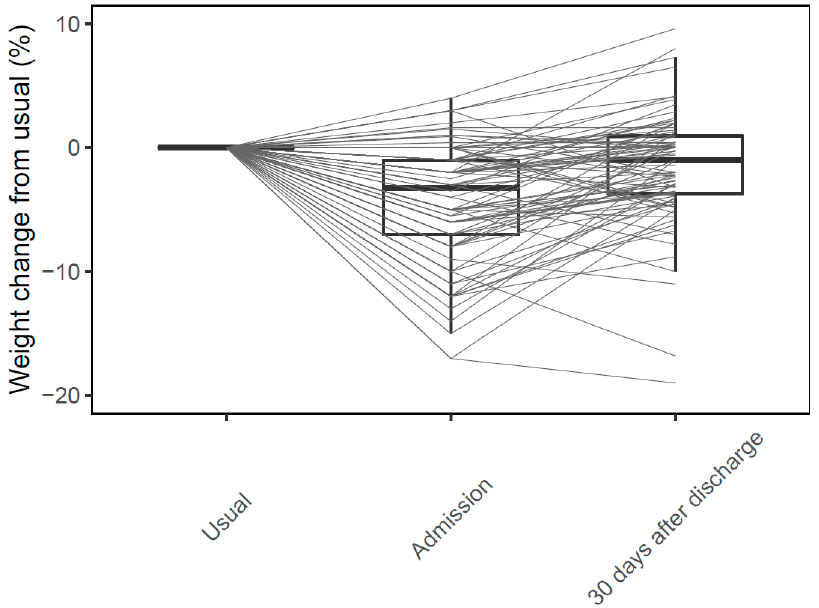
Figure 1. Individual weight change (%) in COVID-19 patients between usual weight, hospital admission and 30 days after discharge.